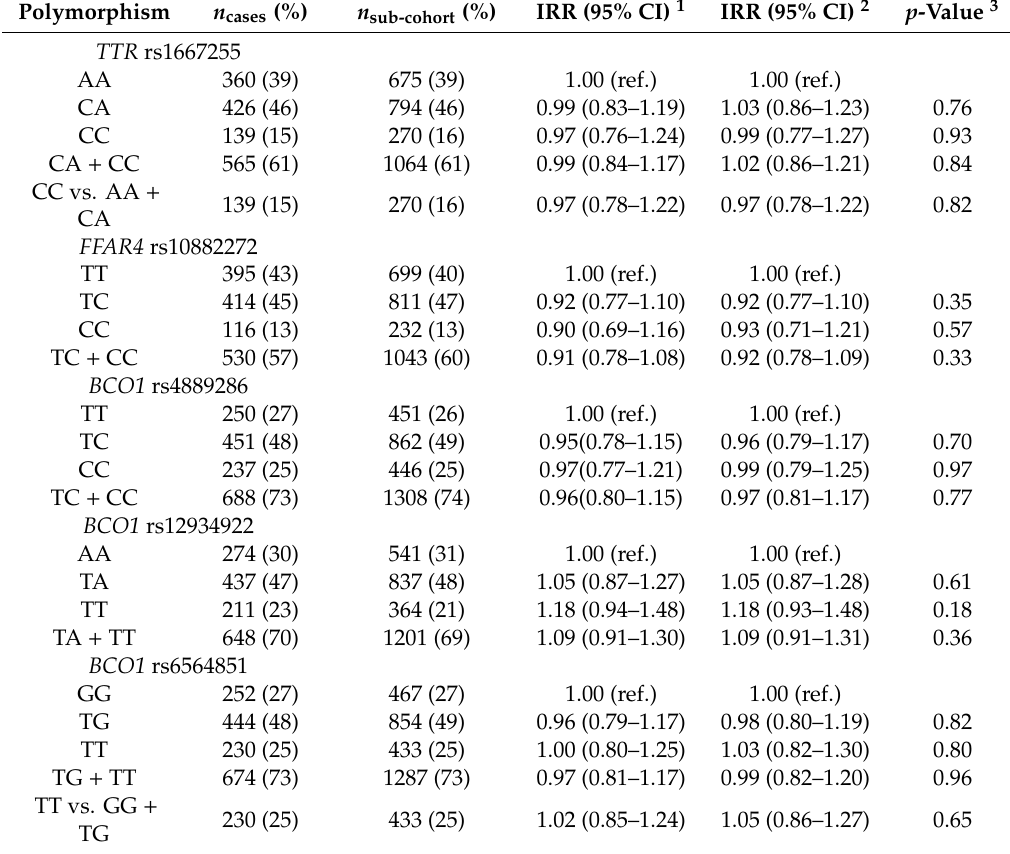
Table 3. Incidence rate ratios (IRR) for associations between the polymorphisms and colorectal cancer (CRC).